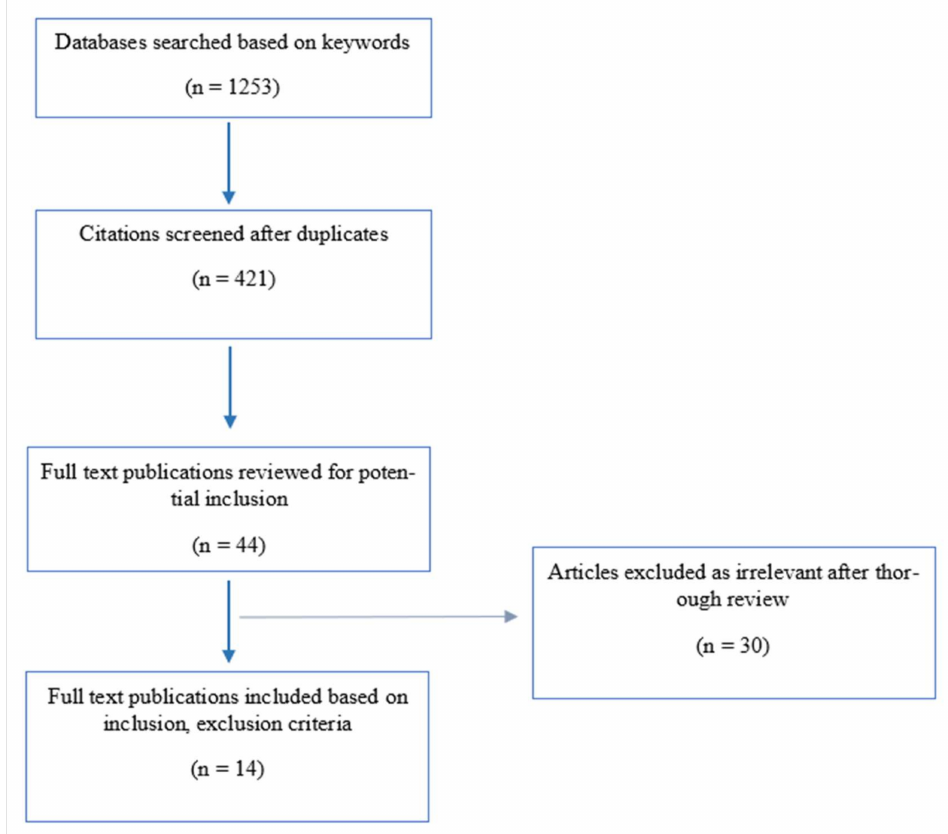
Figure 1. Flowchart on the literature selection process based on guidelines by Ferrari